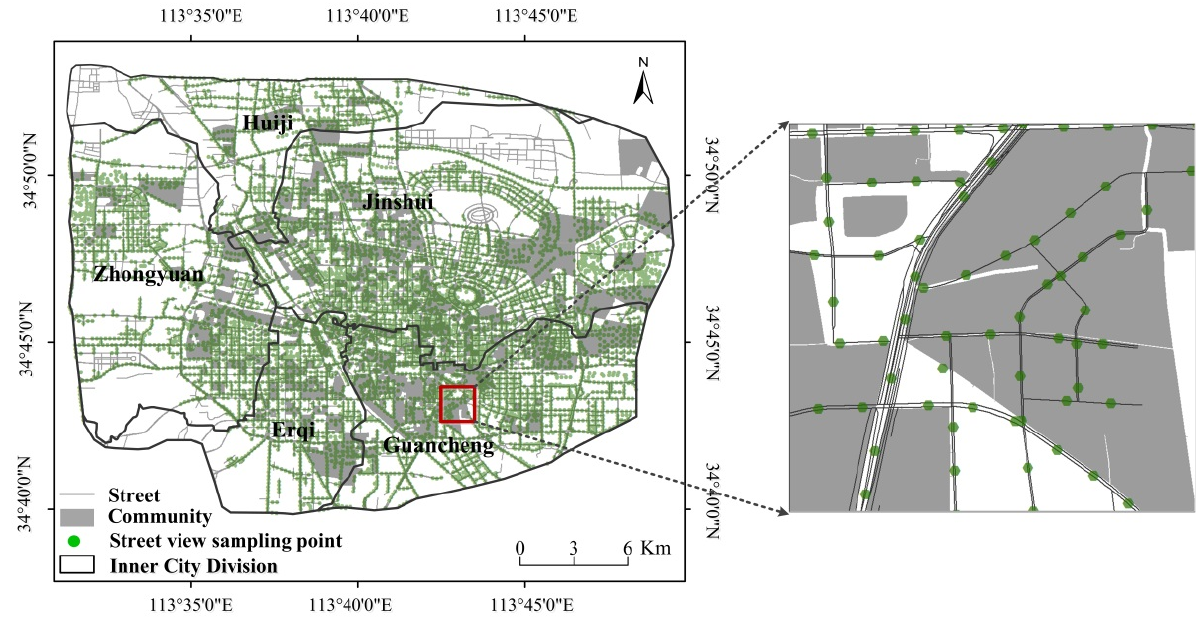
Figure 1. Study area.